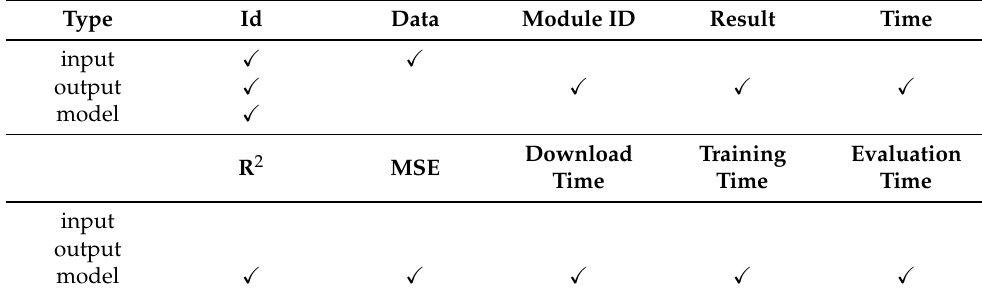
Table 4. Attributes of data